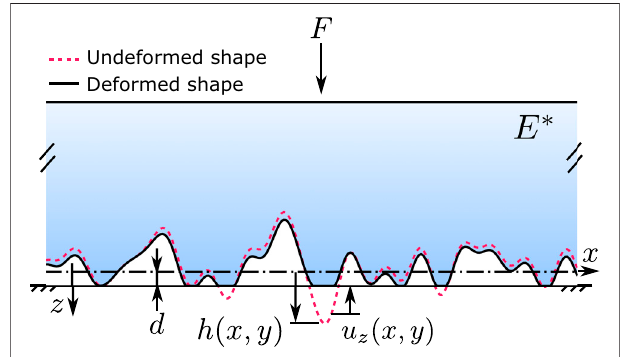
FIGURE1 | Schematic of an elastic half-space withan arbitrarily shaped boundary in purely normal contact with a rigid fl at.